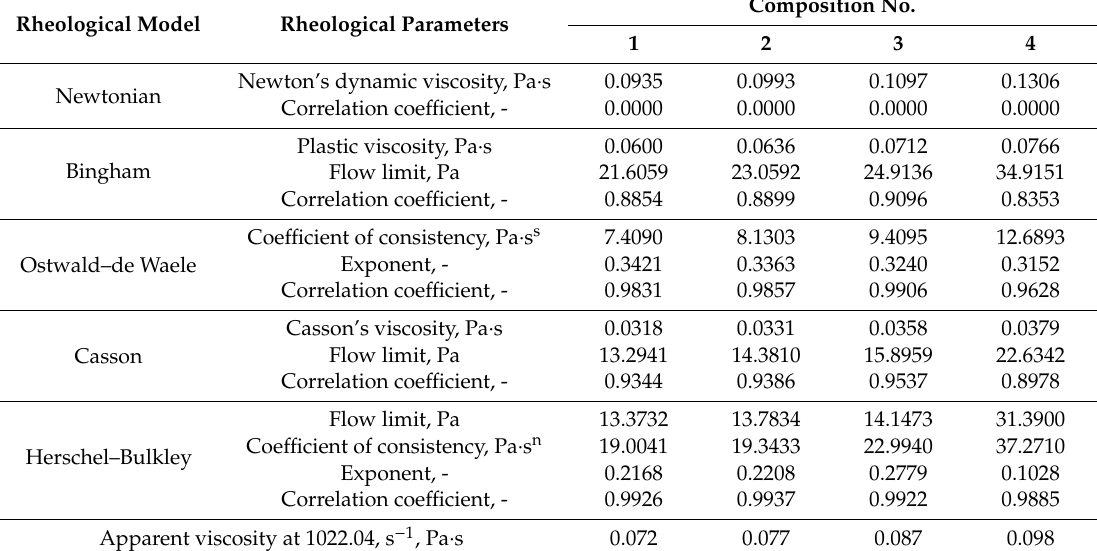
Table 2. Parameters of selected rheological models for slurries prepared with graphene oxide without a latex